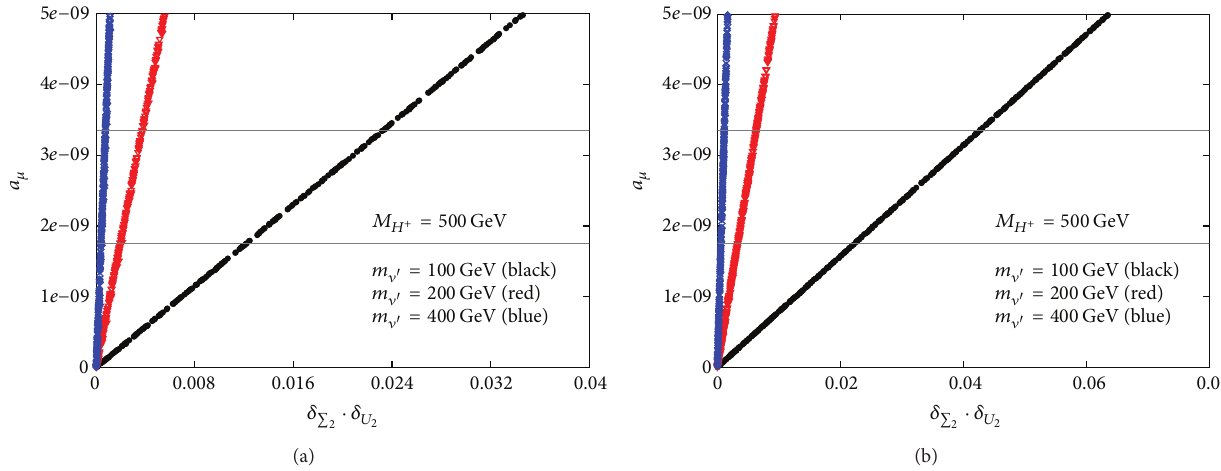
= 𝑚 𝑚 = 500 GeV (a) and 𝜏 󸀠 ] 󸀠 and with 𝐻 +